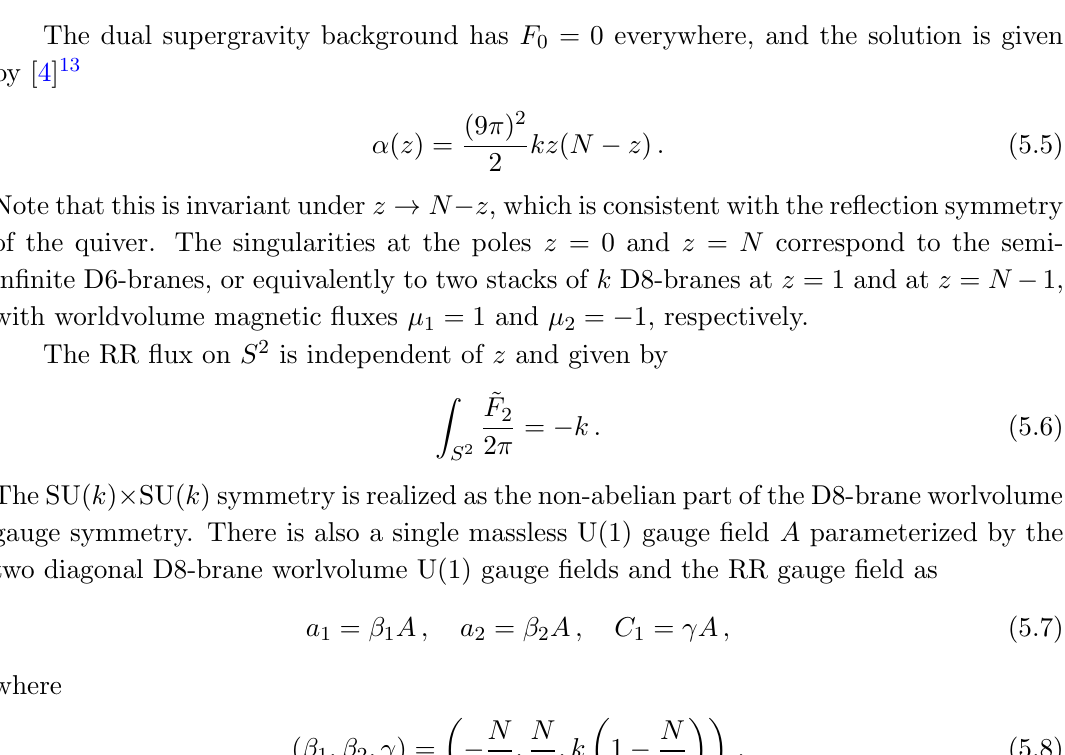
3 dual to the uniform